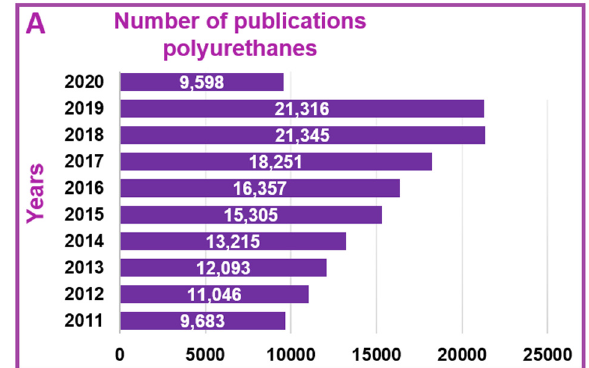
Figure 4. Articles published in the last 10 years related to: ( A ) polyurethanes; and ( B ) polyurea. These numbers were generated from the “Web of Science database” using the keywords “polyurethanes” for ( A ), and “polyurea” for ( B ). (Date data acquired: 15 July 2020). Figure 5. Dynamic bond exchange in self-healing polyurethane network [64].